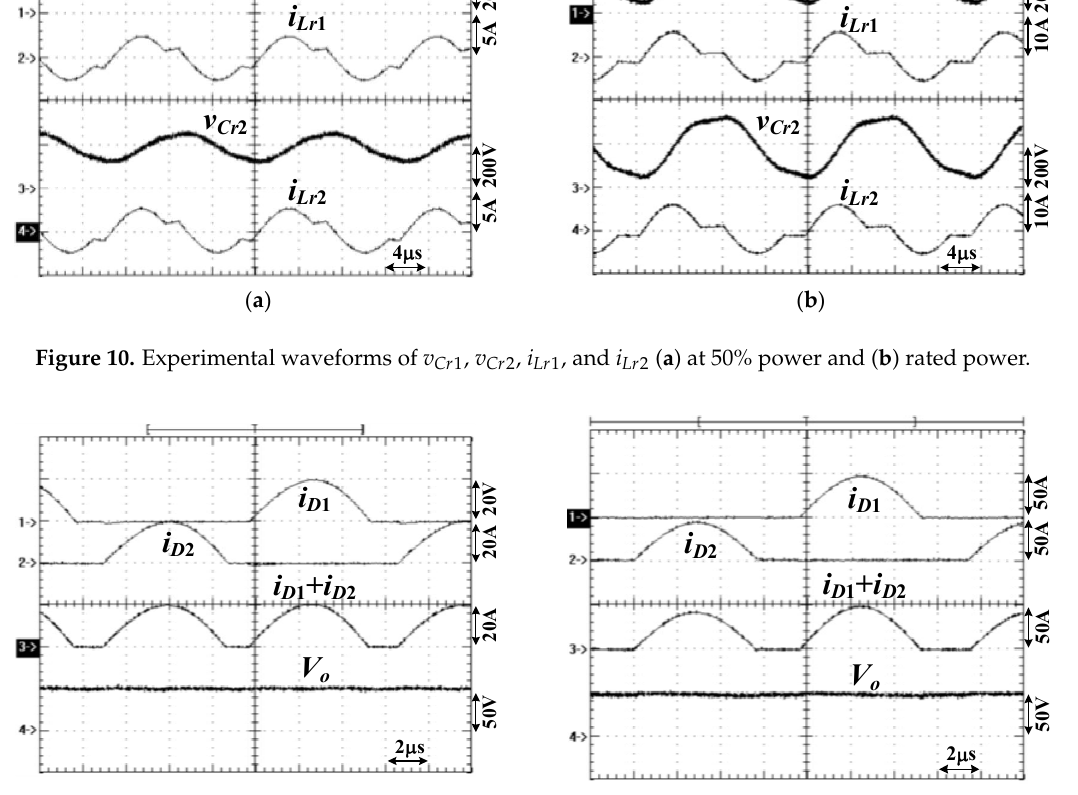
Figure 11. Test waveforms of diode currents and output voltage ( a ) at 50% power and ( b ) rated power.